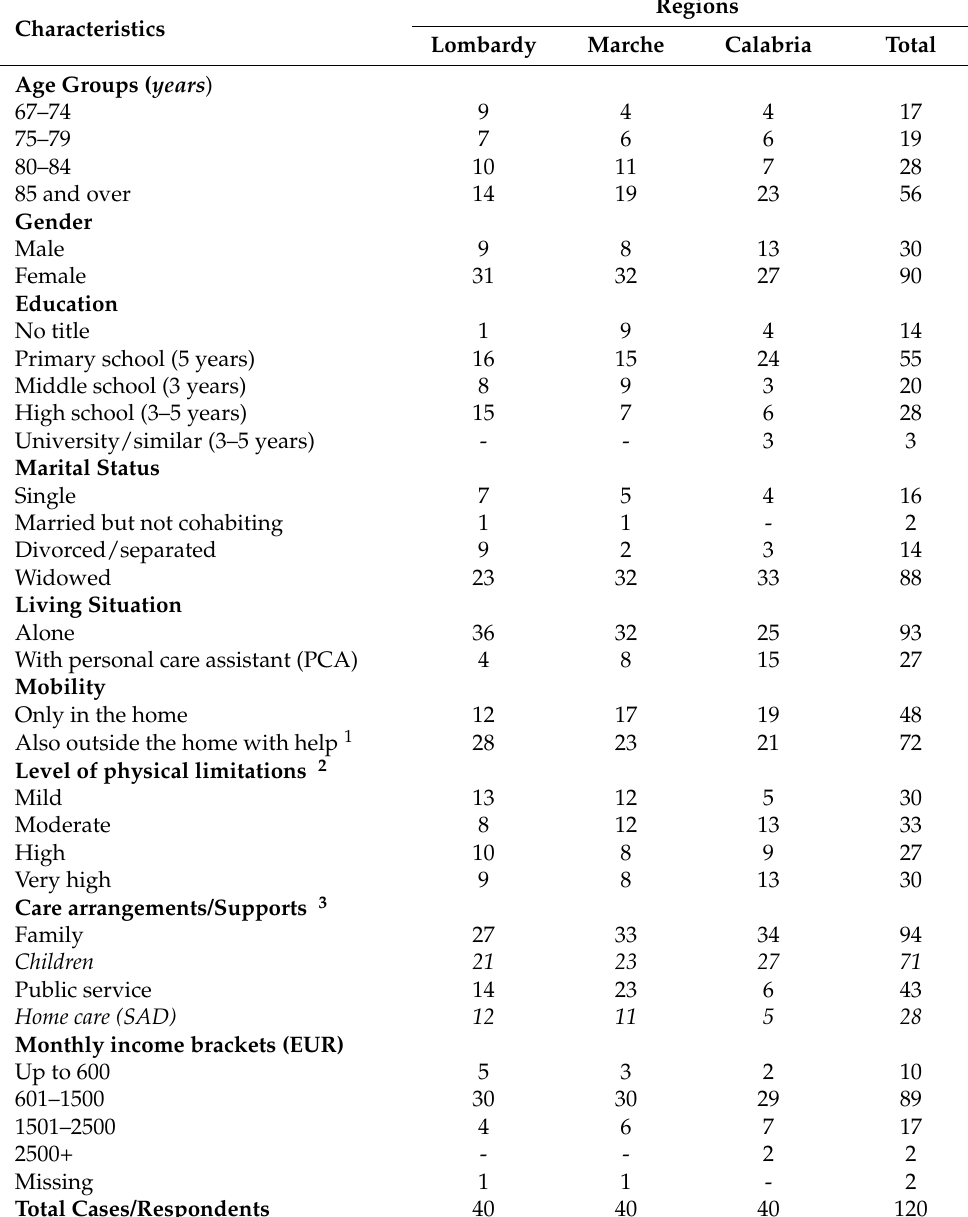
Table 2. Sample characteristics (absolute values/ n